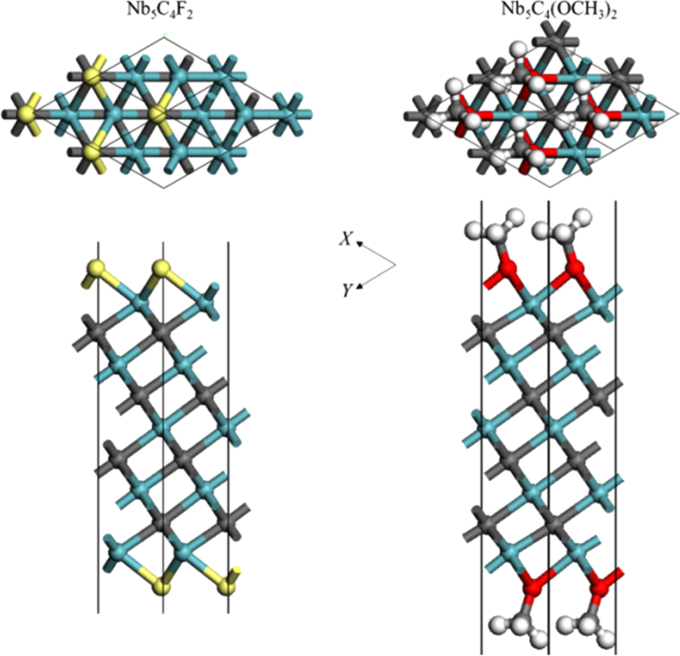
Top views and side views from the X direction of the optimal structures of Nb5C4F2 and Nb5C4(OCH3)2. The atoms represented by different color balls are the same as in Fig. 2.